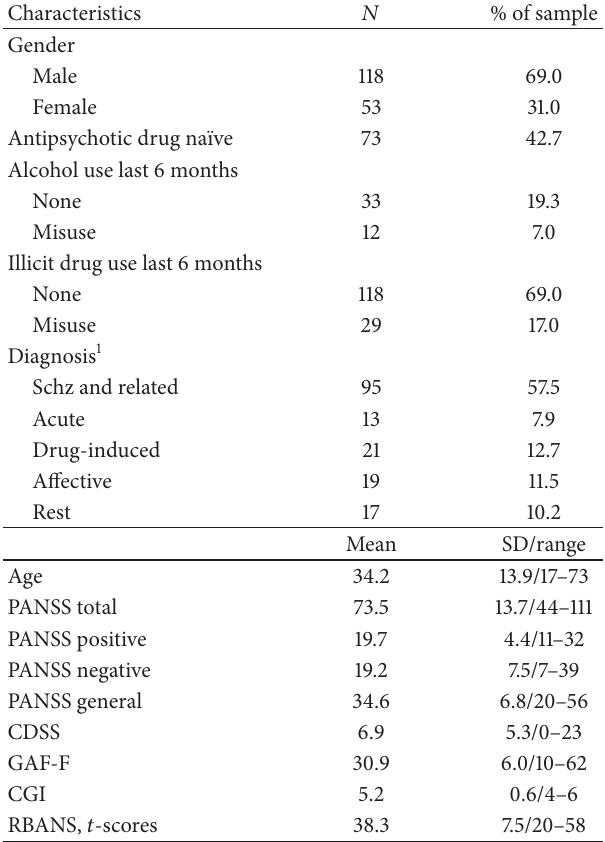
Table 1: Baseline demographics and clinical